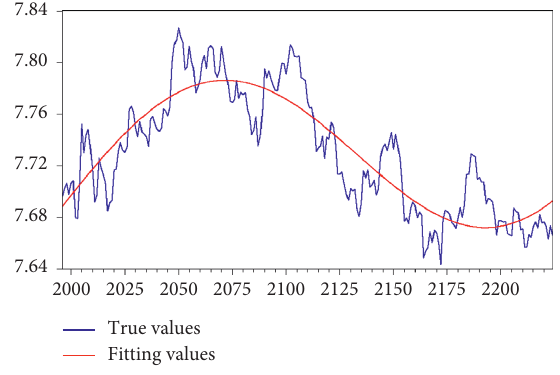
Figure 14: Fitting results from 2009/12 to 2010/6.